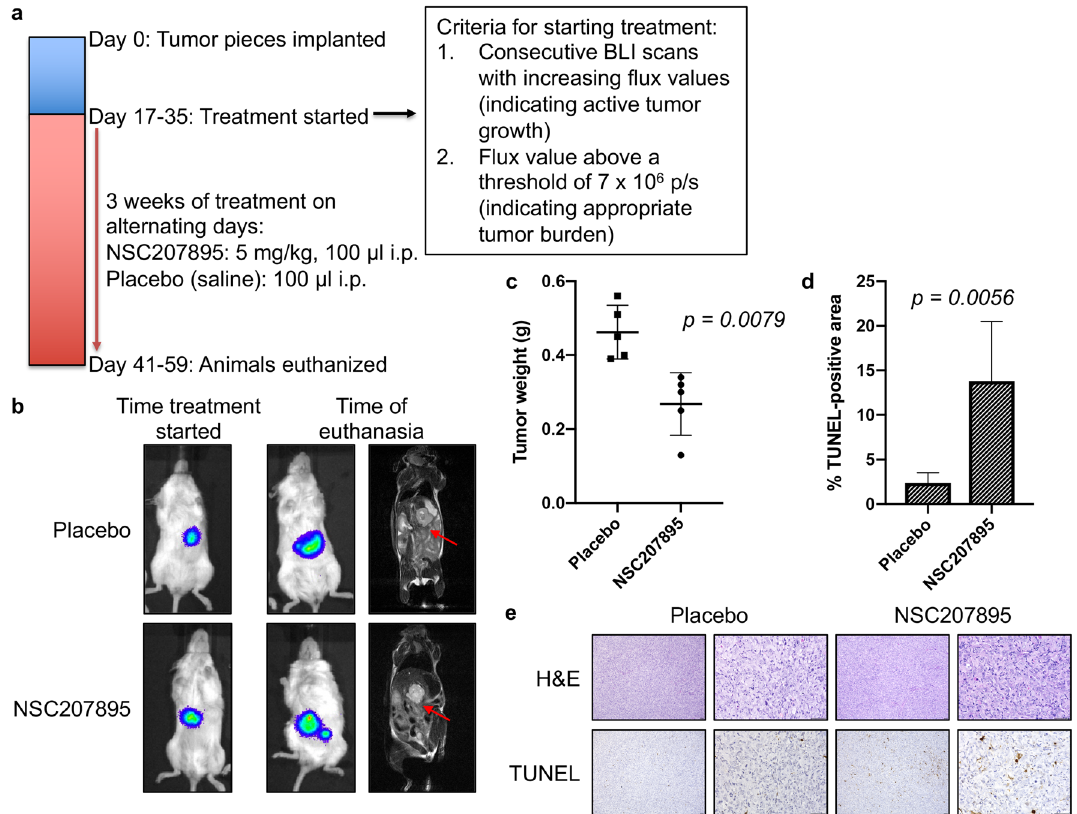
Figure 8. In vivo efficacy of MDM4 inhibition with an orthotopic xenograft murine model of HB. ( a ) Timeline of the animal study. ( b ) BLI and MRI images at early and late time points show progression of the HepT1- derived tumors in the placebo animals and animals treated with NSC207895. The cell line was stably transduced with luciferase to allow the use of BLI to monitor tumor growth in living animals. ( c ) Tumor weights of the placebo and NSC207895-treated animals at time of euthanasia. Kruskal Wallis test used to show significance. ( d ) Quantification of TUNEL staining of the tumors from the placebo and treatment animals. TUNEL-positive areas from images taken on a Keyence BZ-X710 All-in-One Fluorescence Microscope were quantified using the Keyence Hybrid Cell Count Analysis Application. Error bars represent SD. Student’s t test * P < 0.05, ** P < 0.01, *** P < 0.001. ( e ) Representative pictures of H&E and TUNEL staining quantified in d. Scale bars represent 50 μm in 10X and 40X